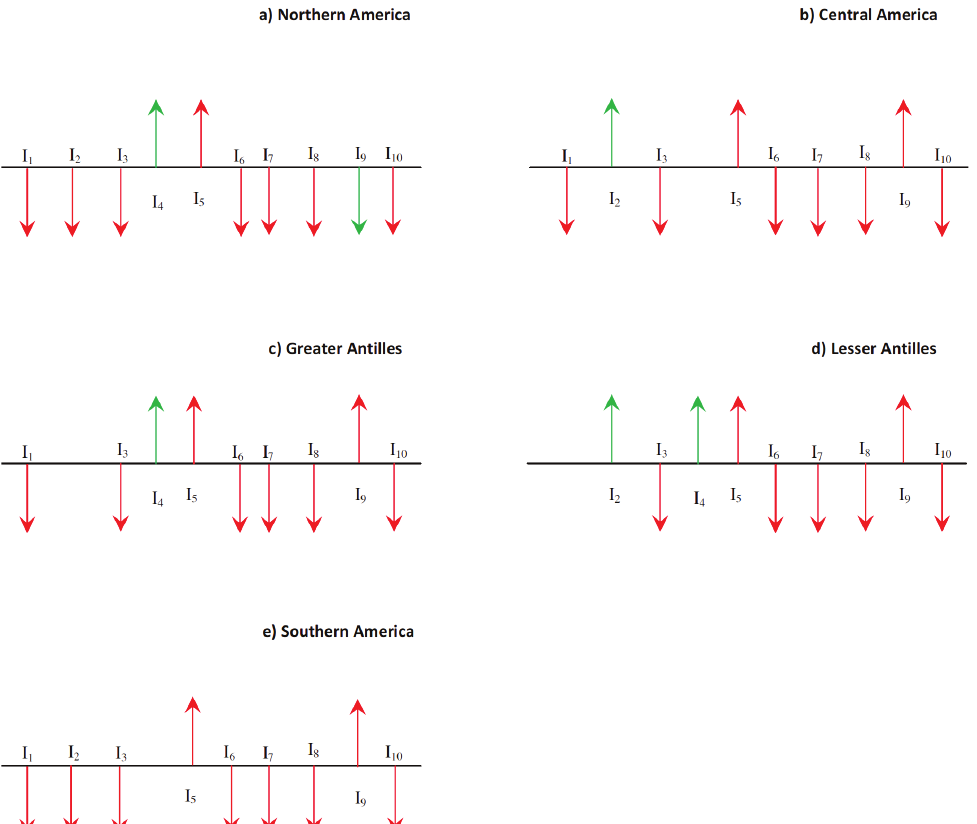
Figure 11: A binary (qualitative) diagram to specify status of the main indexes in different regions of Americas (ignore the exceptions), I1 indicates permanent crops to cultivated area, I2 indicates rural population to total population, I3 indicates total economically active popula- tion in agriculture to total economically active population, I4 indicates HDI, I5 indicates NRI, I6 indicates value added to GDP by agriculture, I7 indicates Irrigation water requirement, I8 indicates percent of total cultivated area drained, I9 indicates difference between NRI and irrigation water requirement, and I10 indicates area equipped for irrigation to cultivated